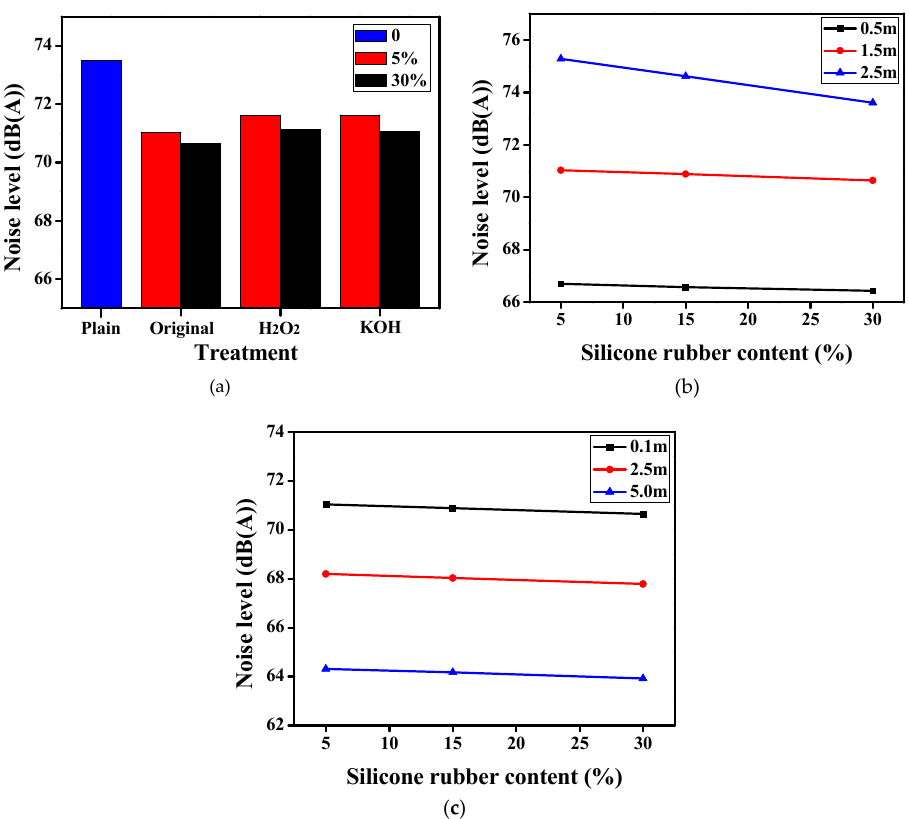
Figure 15. Effect of test conditions on the noise level of silicone rubber mortar. ( a ) Modification method (measuring distance: 0.1 m; falling height: 1.5 m); ( b ) Falling height (original silicon rubber; measuring distance: 0.1m); ( c ) Measuring distance (original silicon rubber; falling height: 1.5 m).